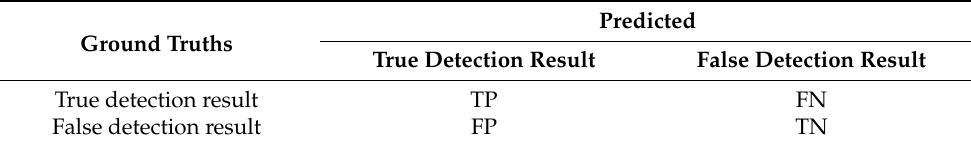
Predicted Ground Truths True Detection Result False Detection Result True detection result TP FN False detection result FP